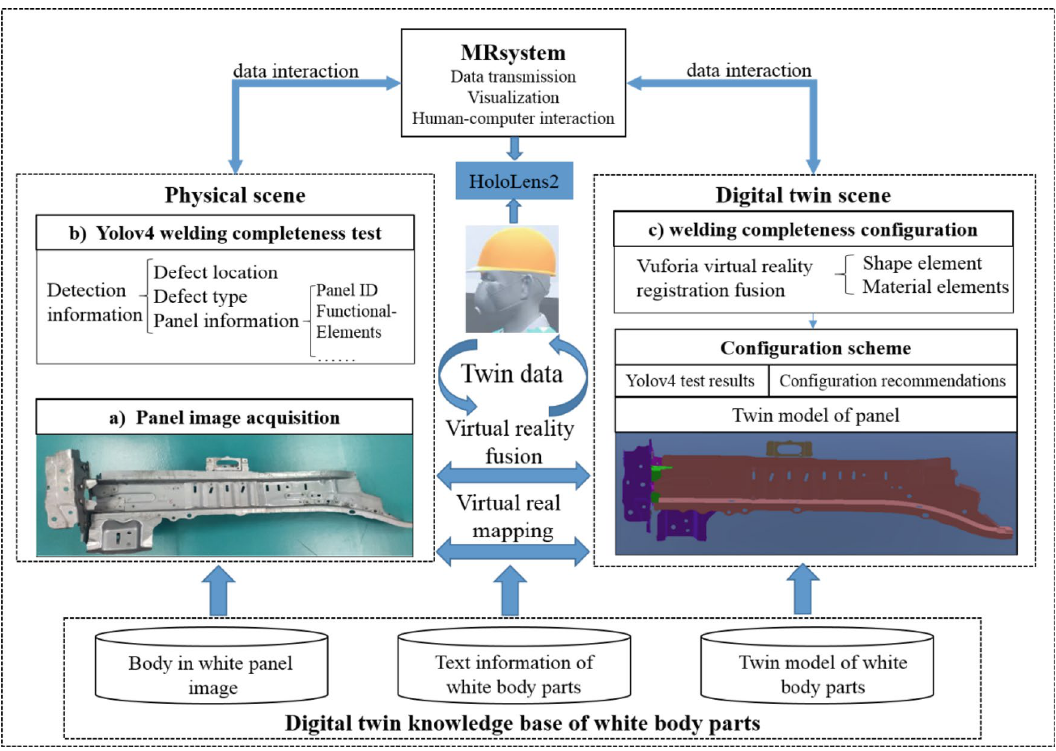
Figure 1. Detection and configuration framework for welding completeness of body in white panels based on digital